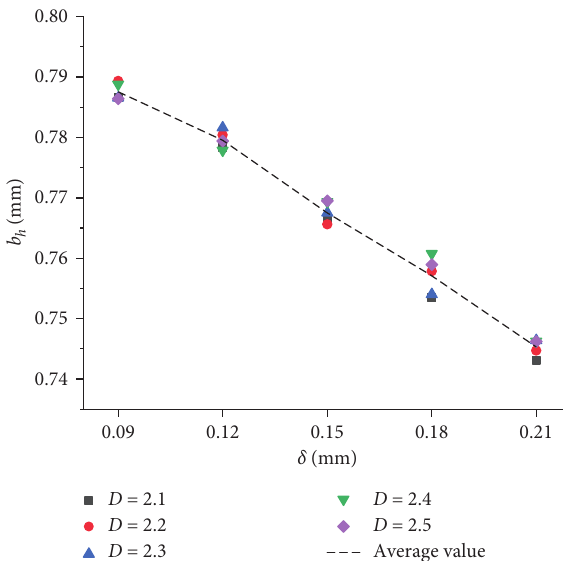
Figure 6: Relationship between the hydraulic aperture and geometric